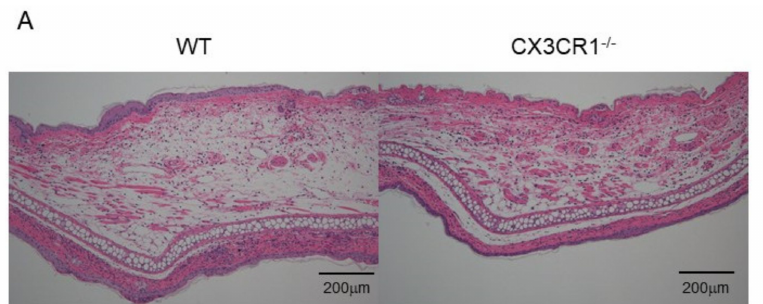
by Mann–Whitney U-test. ( B ) Wild-type mice and CX3CR1 − / − mice were treated with 0.5% DNFB on the right ear without sensitization. Ear swelling was measured before and at 24, 48, and 72 h